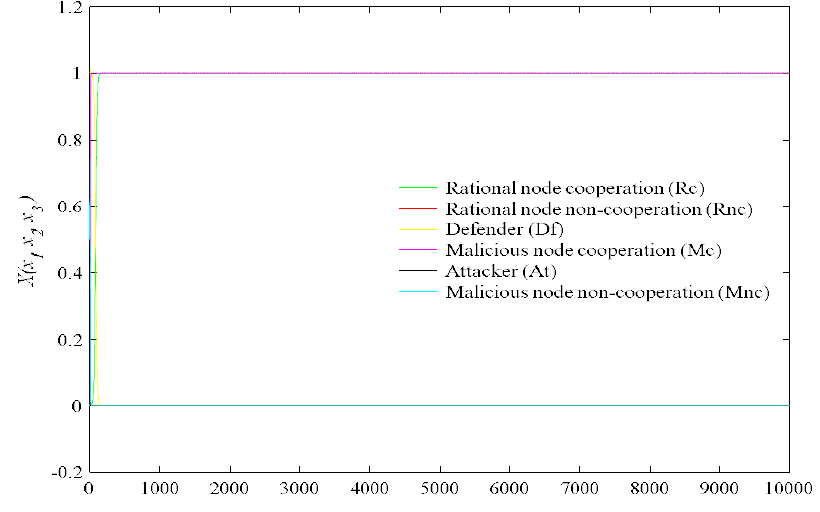
Figure 10. All rational nodes choosing defender strategies and Rc ≠ 0. Table 6. Statistical analyses of strategies R c , R nc , D f , M c , A t